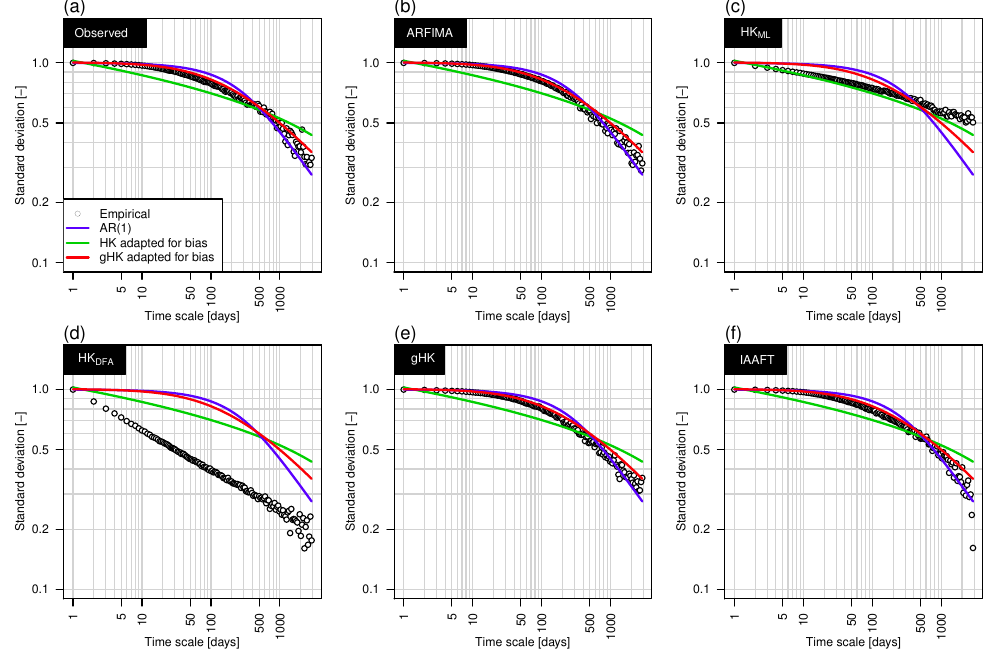
Figure 5. Example of climacograms of observed and simulated series for the Elbe River at Magdeburg-Strombruecke. Each panel shows empirical climacograms (circles) corresponding to the observed series ( a ) and one example series simulated by ARFIMA ( b ); HK ( c , d ); gHK ( e ); and IAAFT ( f ). Each panel also shows the biased corrected theoretical climacograms for the first-order autoregressive AR(1) model, HK, and gHK fitted on the observed